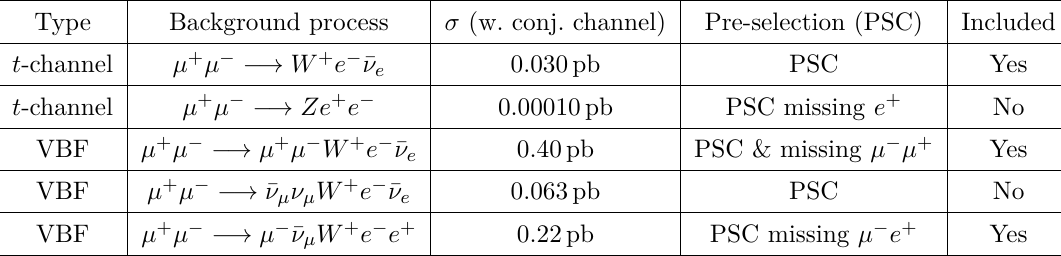
Table 8 . N e background at 10 TeV. The cross section includes the charge conjugate process. neutrino mass m can be reconstructed through the invariant mass of the hadronic W and N ‘ (charged lepton) system. We impose mass-window cut on m and generally consider N the transverse momentum p , pseudorapidity η , and energy E of the charged lepton ‘ and T hadronic weak boson. Selection cuts are chosen to enable a high signal-background ratio while conservatively not too narrow to allow for unaccounted experimental effects. These considerations enable us to derive realistic projections on muon collider physics potential on